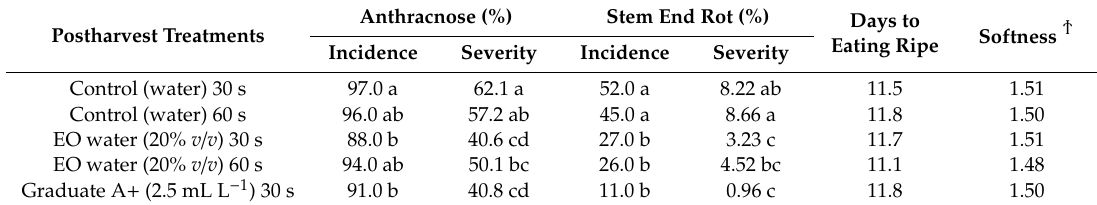
Table 8. E ff ects of electrolyzed oxidizing (EO) water and synthetic fungicide applied via simulated Table 2. Effect of electrolyzed oxidizing (EO) water and synthetic fungicides on postharvest diseases commercial packing line on postharvest diseases and ripening properties of avocado (cv. Hass), Trial 5. and ripening properties of avocado cv. Hass, Trial 1.